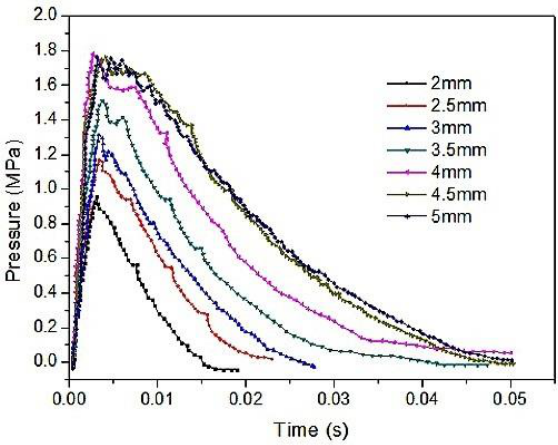
Figure 16. The pressure – time curve of fine-grained Fe/Al energetic jets and control scheme.